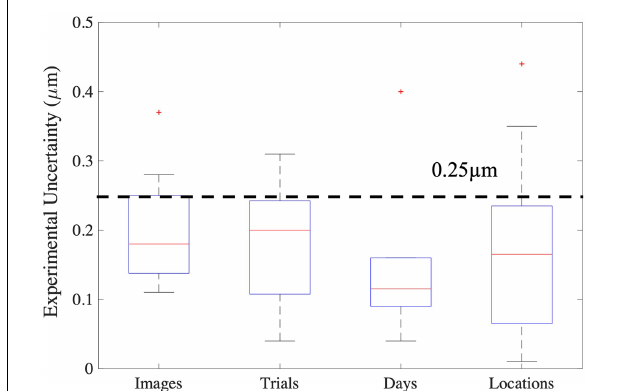
FIGURE 8 | Boxplots of the various sources of experimental uncertainty investigated in this study. The red line represents the median, the blue box extends from the 25th to the 75th percentile of the data, and the dashed error bars, referred to as whiskers, represent the range of all data excluding outliers (red “+”). For images the y-axis represents the standard deviation in mean sarcomere length across images. For all other x-axis elements, the y-axis represents the absolute difference in mean sarcomere length between trials, days, and